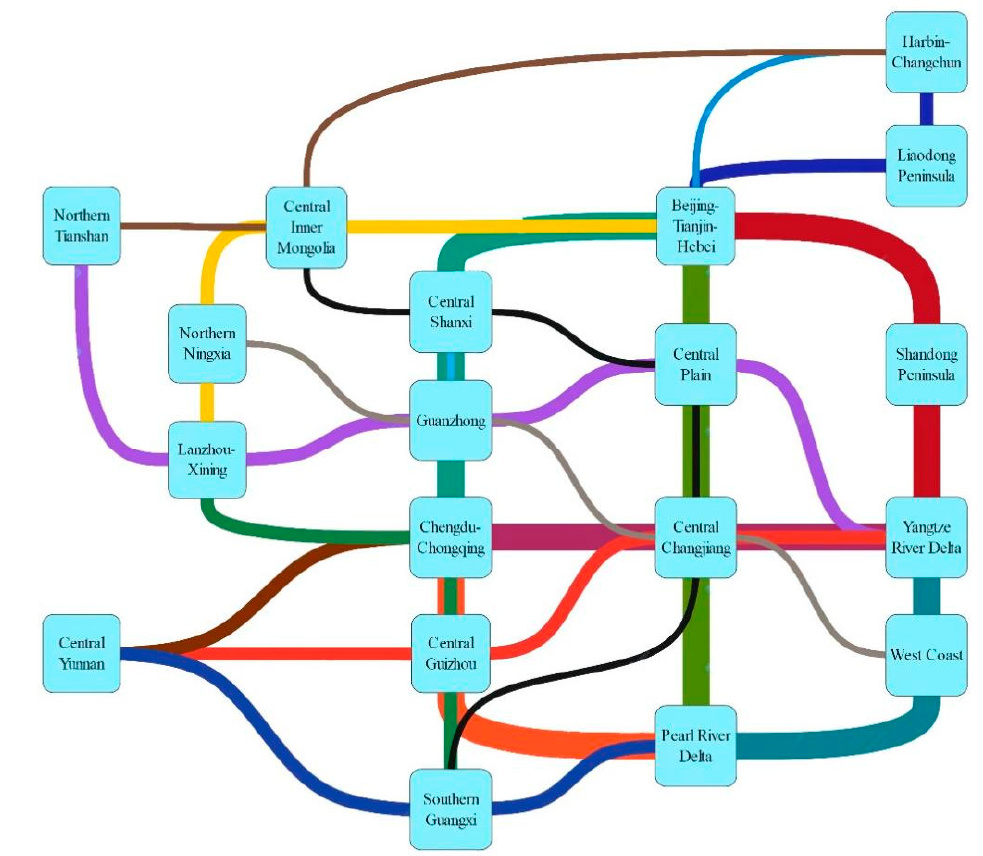
Figure 3. Schematic diagram of national urban agglomerations and main roadways.